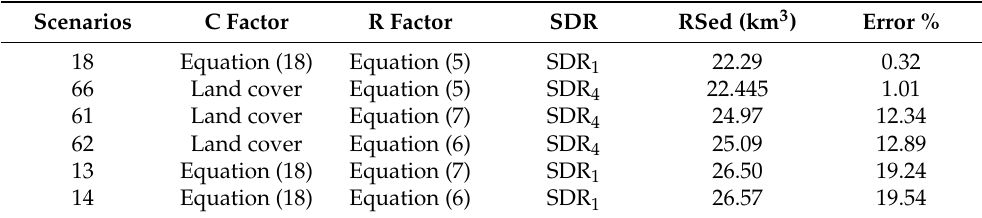
Table 12. The results of the best scenarios, which have error rates less than 20% in the Darbandikhan Lake for the period between November 1961 and May 02,